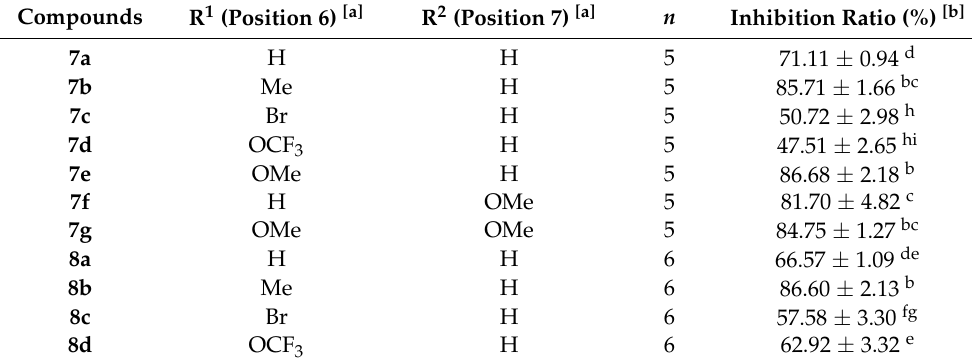
Figure 2. Synthesis routes of target product coumarin–BMT hybrid. Reagents and conditions: ( a ) AlCl 3 , Toluene, NaOH, 140 ◦ C, reflux. ( b ) HCl, NaNO 2 , SnCl 2 ; ( c ) phenol, NaI, N 2 , 180 ◦ C, reflux; ( d ) (CH 2 O) n , MgCl 2 , CH 3 CN, Et 3 N,95 ◦ C, reflux; ( e ) CH 2 (CO 2 C 2 H 5 ) 2 , HAC, EtOH, 95 ◦ C, reflux; Table 1. Inhibitory activity of Coumarin–BMT hybrids and positive controls against